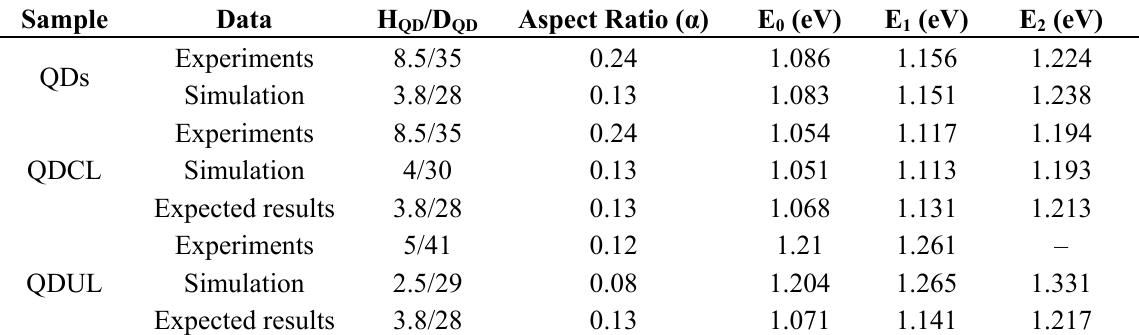
Table 2. Experimental and theoretical Ground state and first two excited states optical transition energies as well as corresponding QD size. The experimental emission energies are given by PL spectroscopy and the average QDs size is estimated through AFM. The expected results refer to the calculated transition energies keeping the simulated buried fitting the theoretical emission energies to the corresponding PL